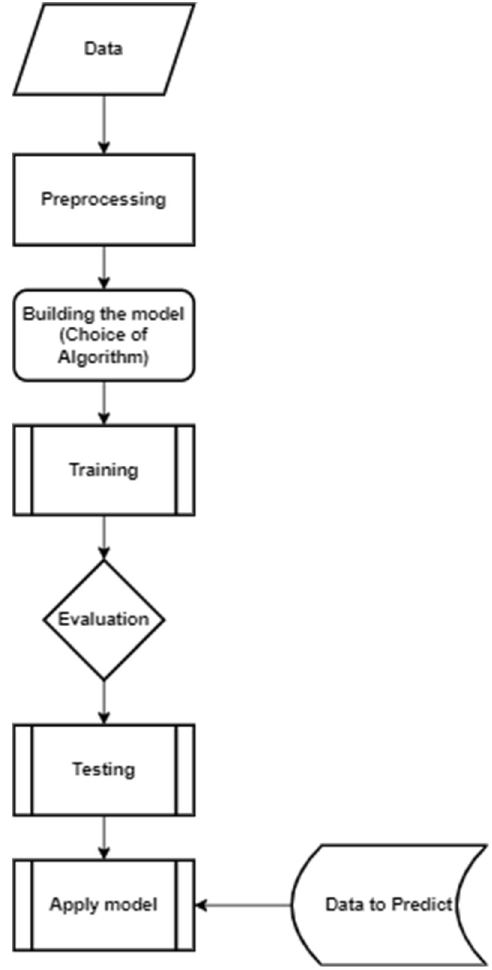
Figure 12. Machine learning model